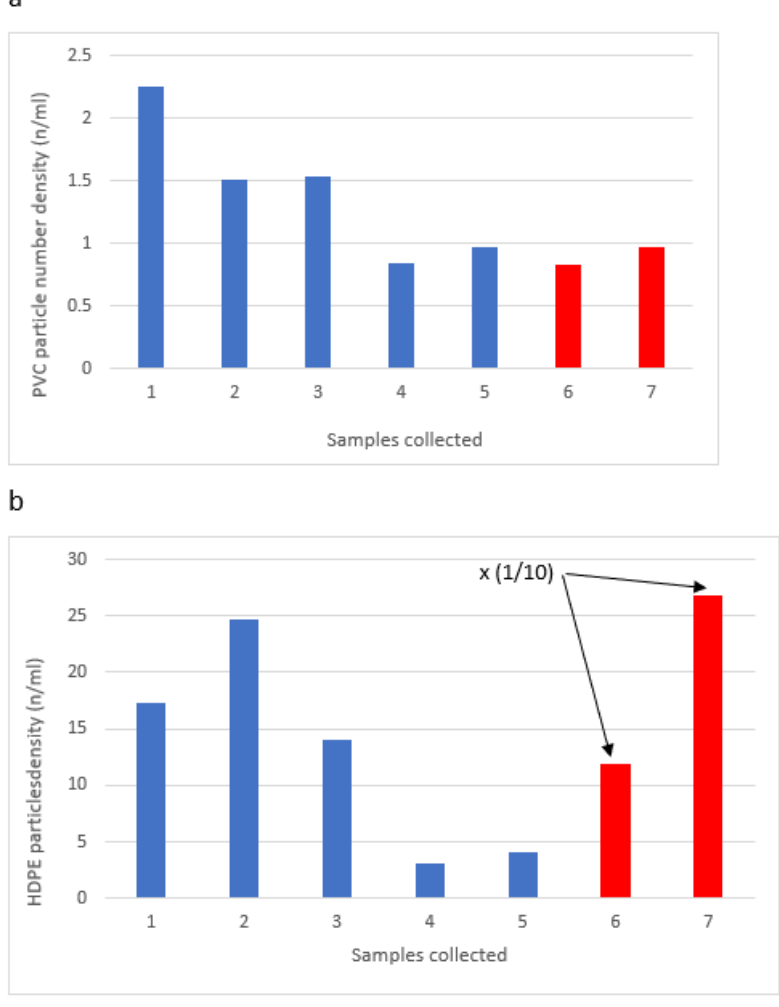
Figure 5. Particle number density (n/mL) of real wastewater/water samples from a WWTP resuspended in the CaCl 2 solution ρ = 1.5 g/cm 3 (panel ( a )) and in the ethanol solution ρ = 0.9 g/cm 3 (panel ( b )). 1: inlet, 2: outlet of the primary settling tank, 3: outlet of the secondary settling tank, 4: